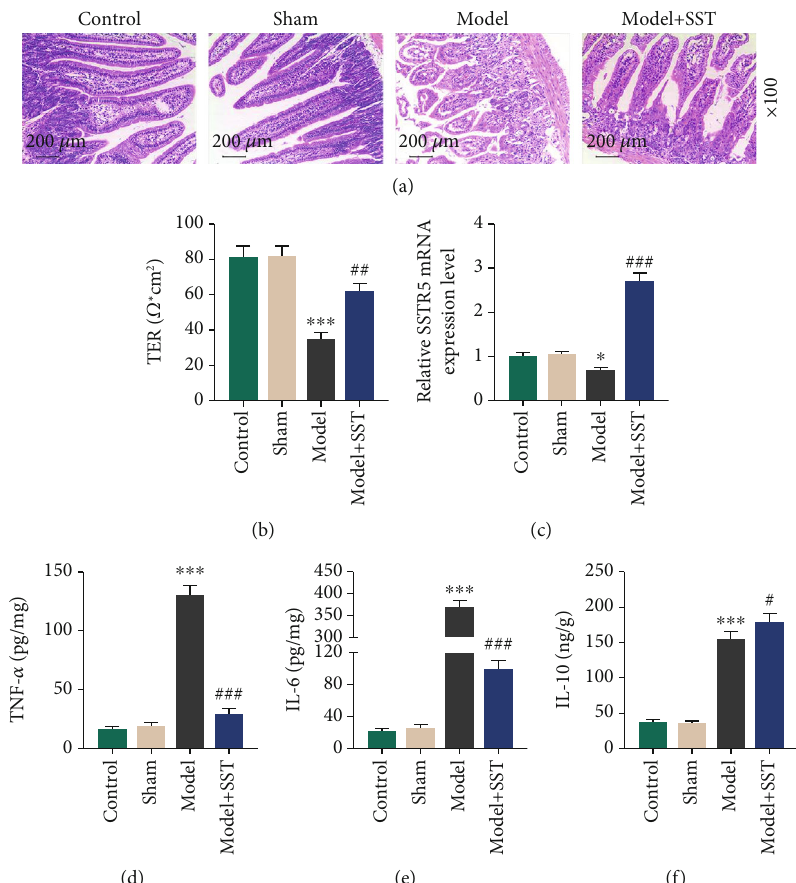
Figure 1: SST prevented sepsis-induced intestinal barrier dysfunction. (a) Intestinal tissue from the control, sham, model, and model+SST group was detected using hematoxylin and eosin (HE) staining. Sections presented ten mice in each group. Magni fi cation: 100x. Scale bar: 200 μ m. (b) TER of gut mucosae was evaluated via transepithelial voltohmmeter. (c) The speci fi c somatostatin receptor subtype SSTR5 was detected by qRT-PCR. (d – f) Detection of in fl ammatory factors, including TNF- α , IL-6, and IL-10 in the ileum using ELISA. Data were shown as the mean ± SD from 3 independent experiments. ∗∗∗ P < 0 : 001 , vs. sham; ### P < 0 : 001 , vs. model. TNF- α : tumor necrosis factor α ; IL-6: interleukin 6; IL-10: interleukin 10; SST: